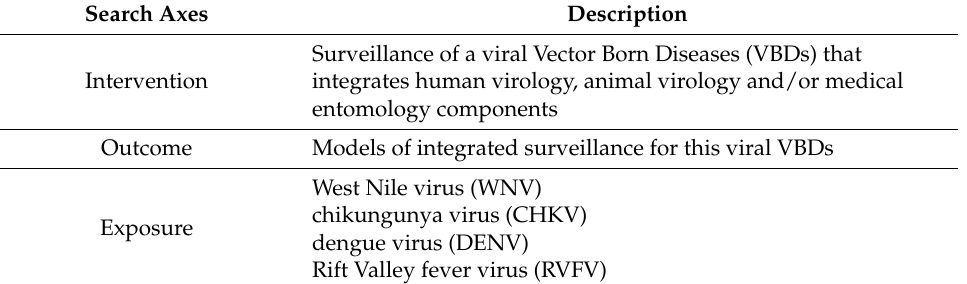
Table 2. Review search axes.